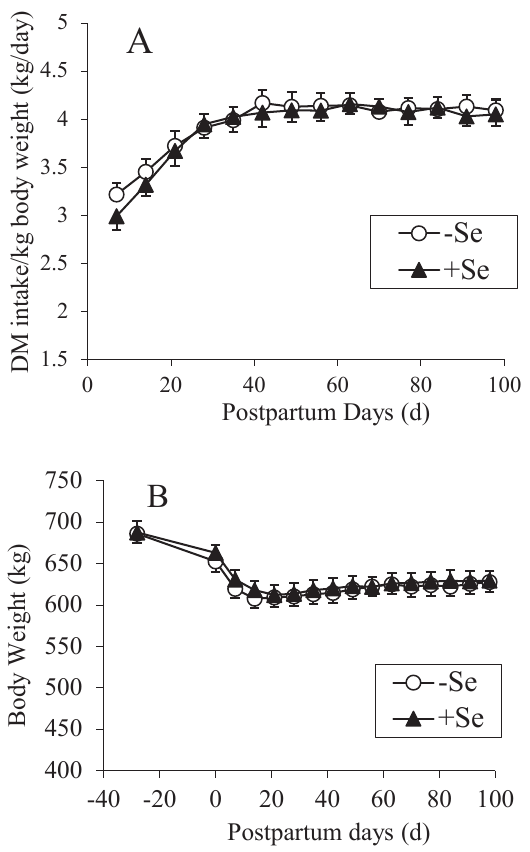
Figure 1. Changes of (A) dry matter (DM) intake (kg), and (B) body weight (kg) (mean±standard error of the mean; -Se: n = 17, +Se: n = 17). DM intake was measured on 3 days each week. Samples of the remaining feed and TMR were dried at 60°C for 48 h in a drying machine. Body weight was measured before feeding in the morning every